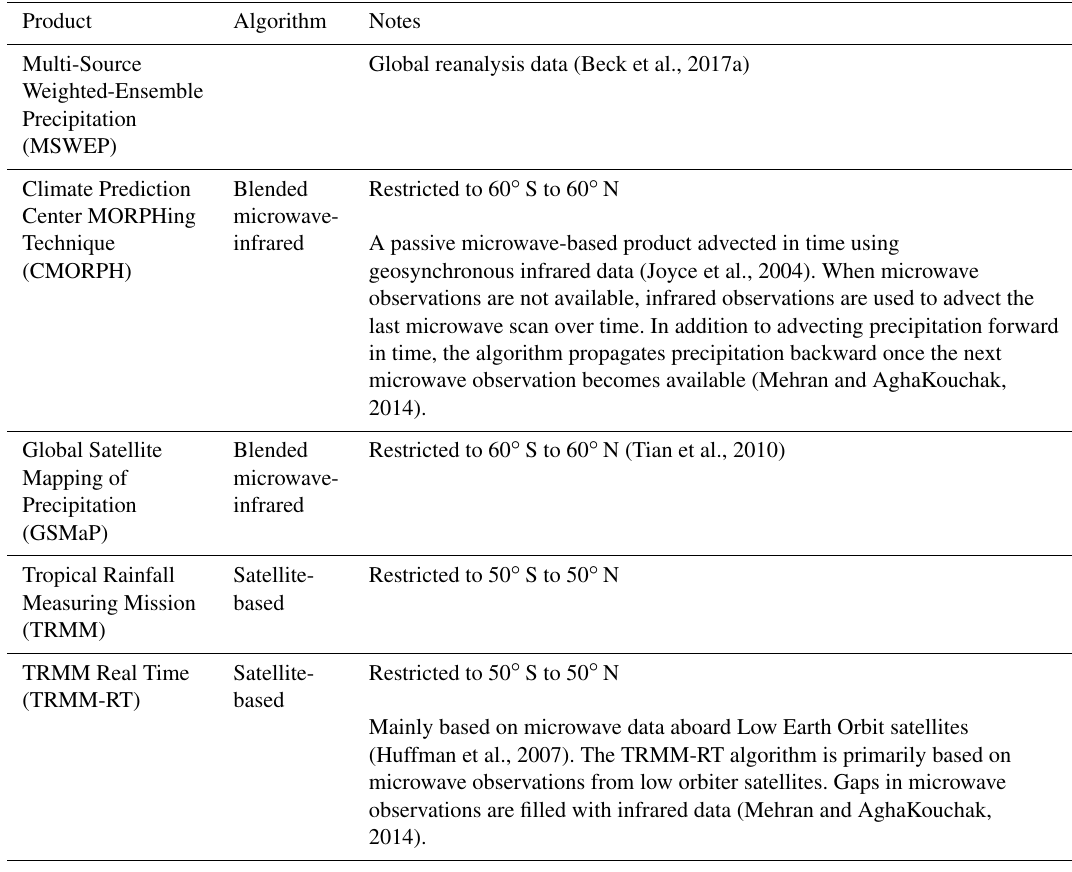
Table 2. Global precipitation products used to drive the models selected from Dorigo et al. (2014). Data files used are available through the Water Cycle Integrator (https://wci.eartH2Observe.eu/, last access: 7 January 2020) at 25km resolution for the period 2000–2013. Algorithm type is as given by the International Precipitation Working Group (IPWG) ∗ .